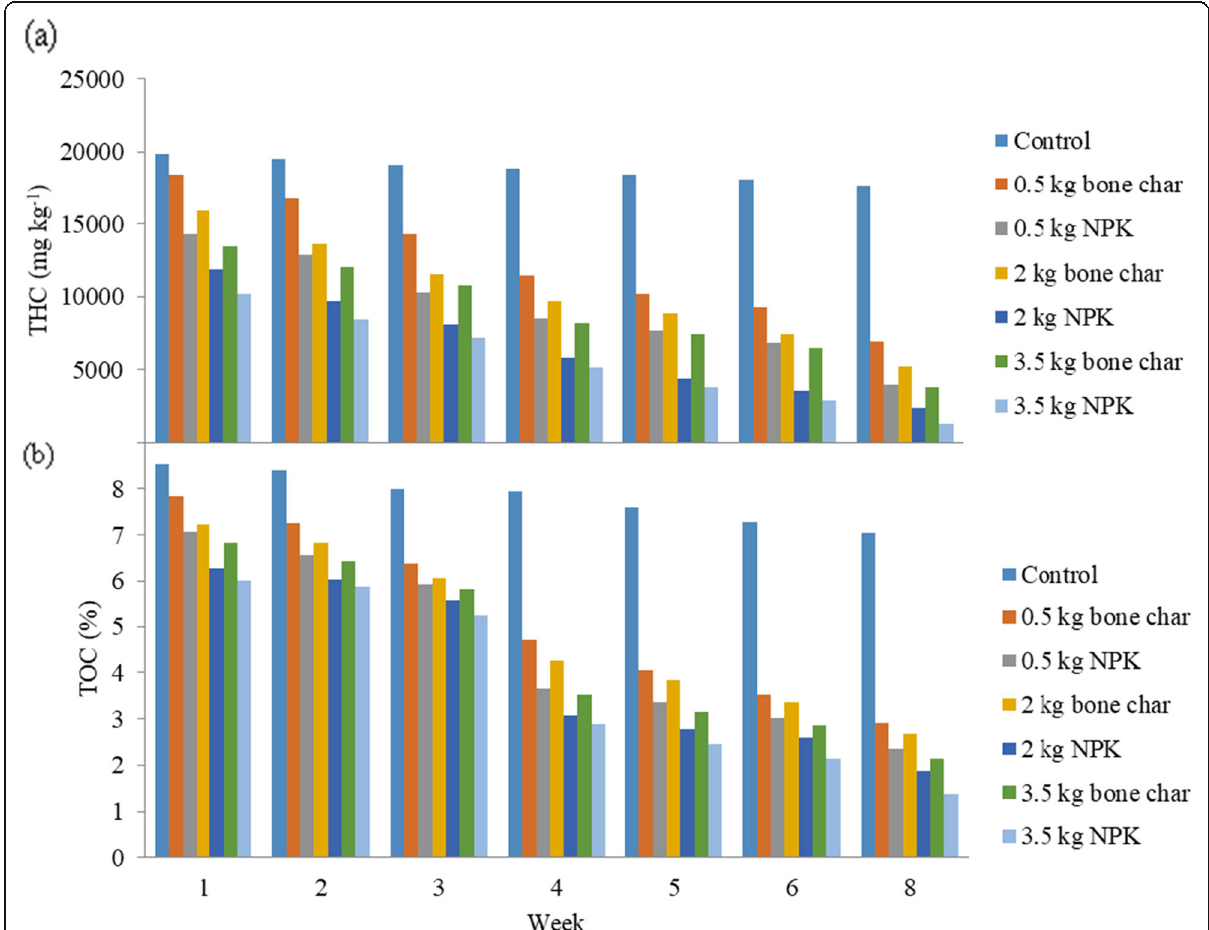
Fig. 2 Effect of bioremediation treatment on ( a ) THC ( b )